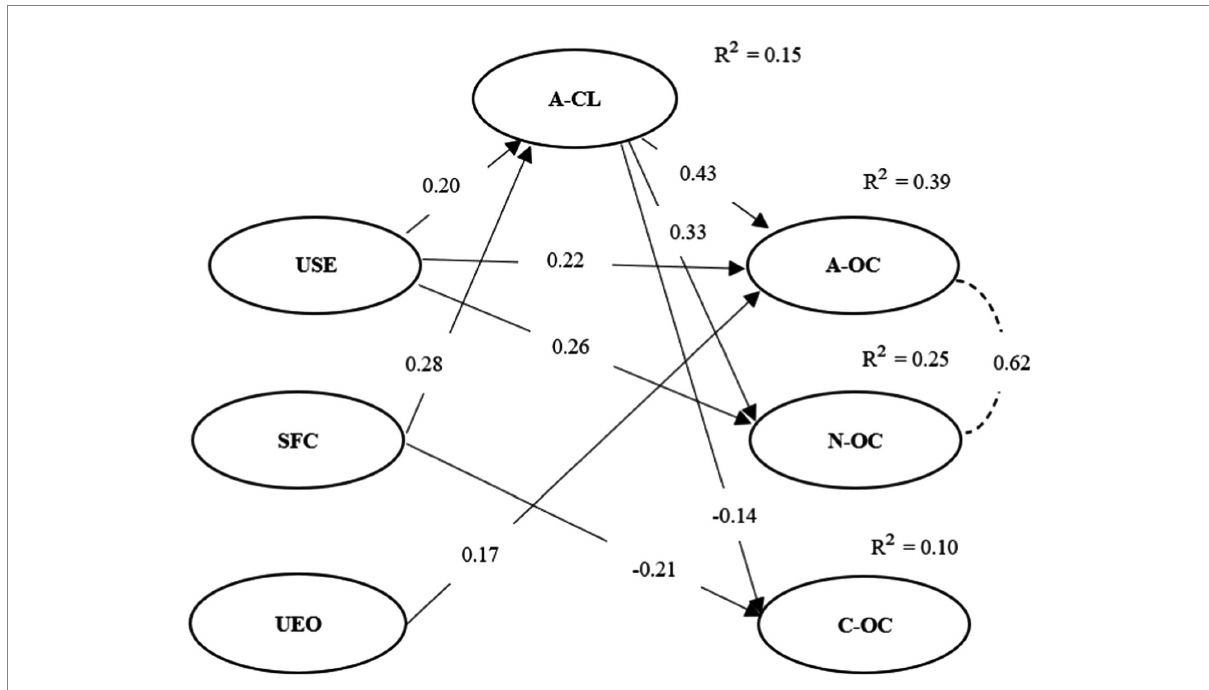
FIGURE 3 Diagram of the final model of the relationship between employees’ emotional awareness, affective commitment to the leader, and organizational commitment.